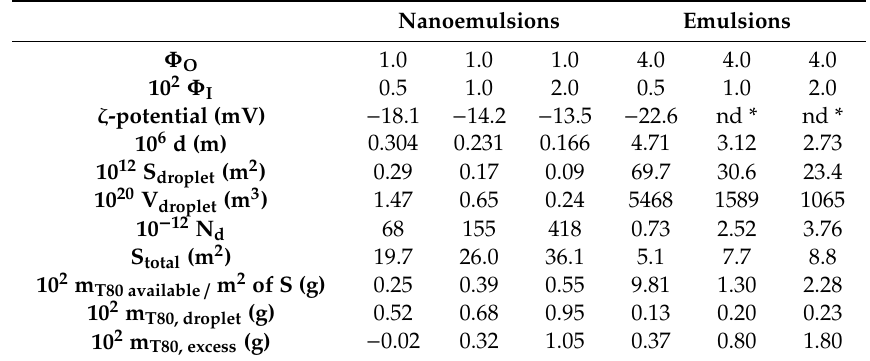
Table 2. Theoretical calculations (assuming that all droplets have the same size within each emulsified system) of some physical characteristics of the prepared (O / W) fish nanoemulsions in the absence of